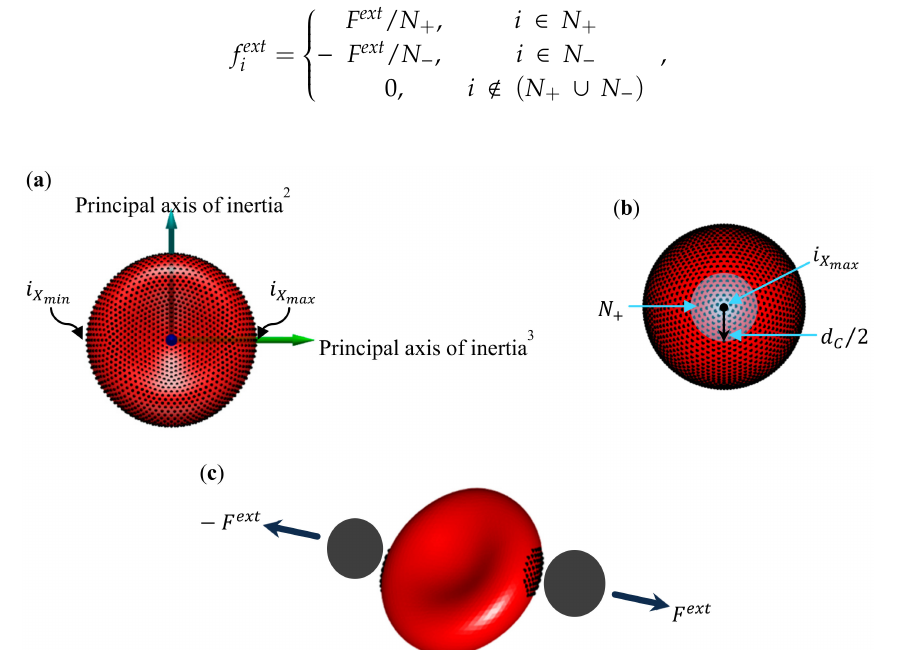
Figure A2. Optical tweezers stretching implementation on the discocyte cell; ( a ) identification of i X and i X vertices, ( b ) identification of N + vertices, and ( c ) contact region between the RBC membrane min and binding silica